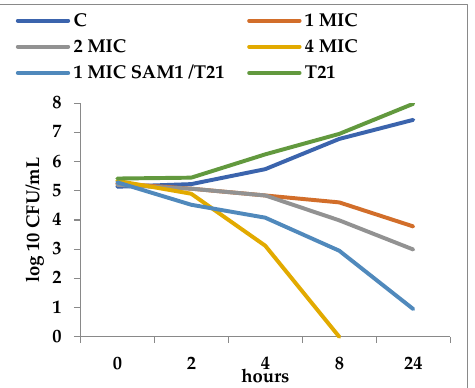
Figure 4. Effect of T21 (0,5%), AM1 (1-4 MIC), and its association with T21 (SAM1 1MIC + T21) on the time-killing dynamics in E. coli ATCC 11229.